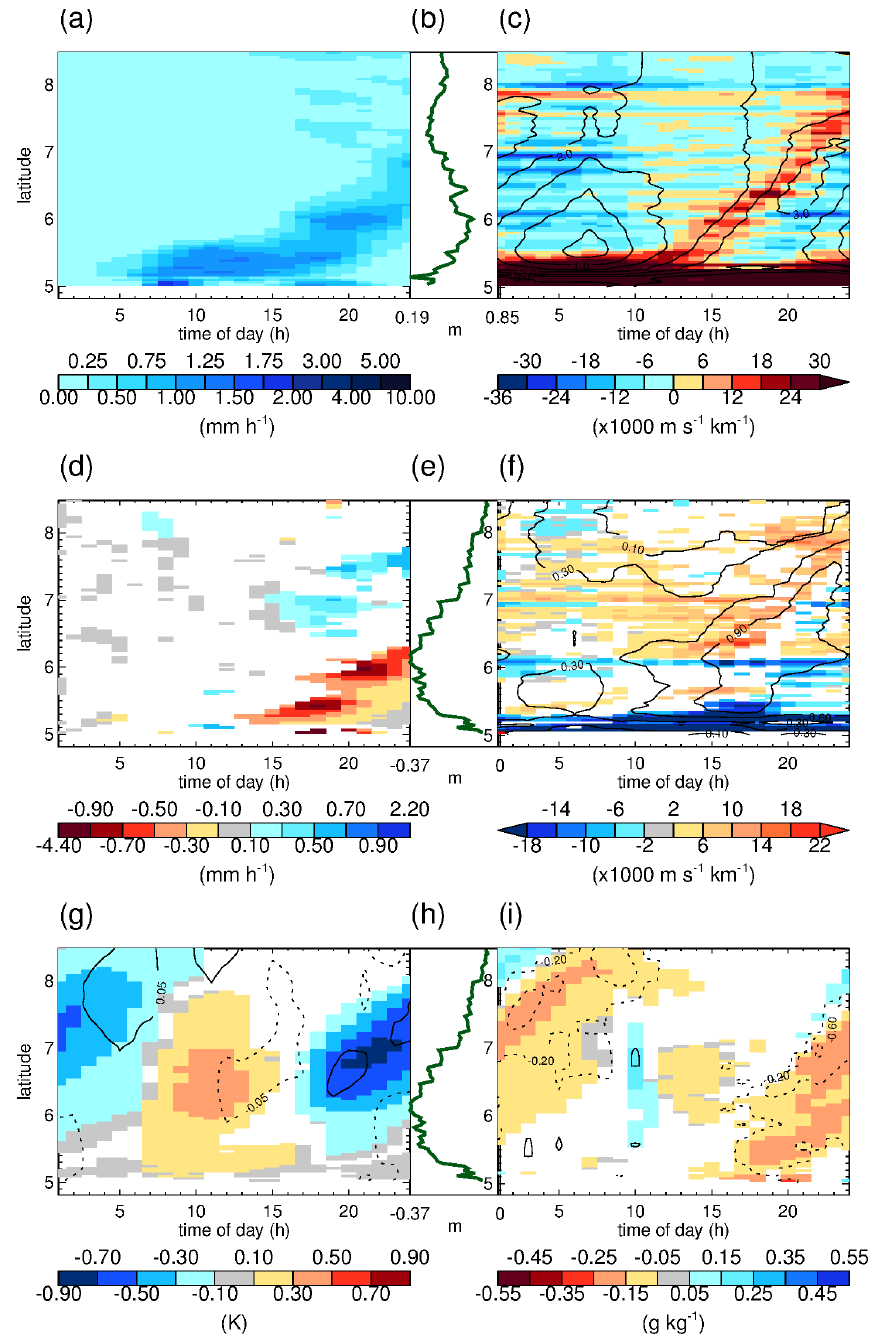
Figure 10. As for Fig. 8 but for cross sections 6–3 ◦